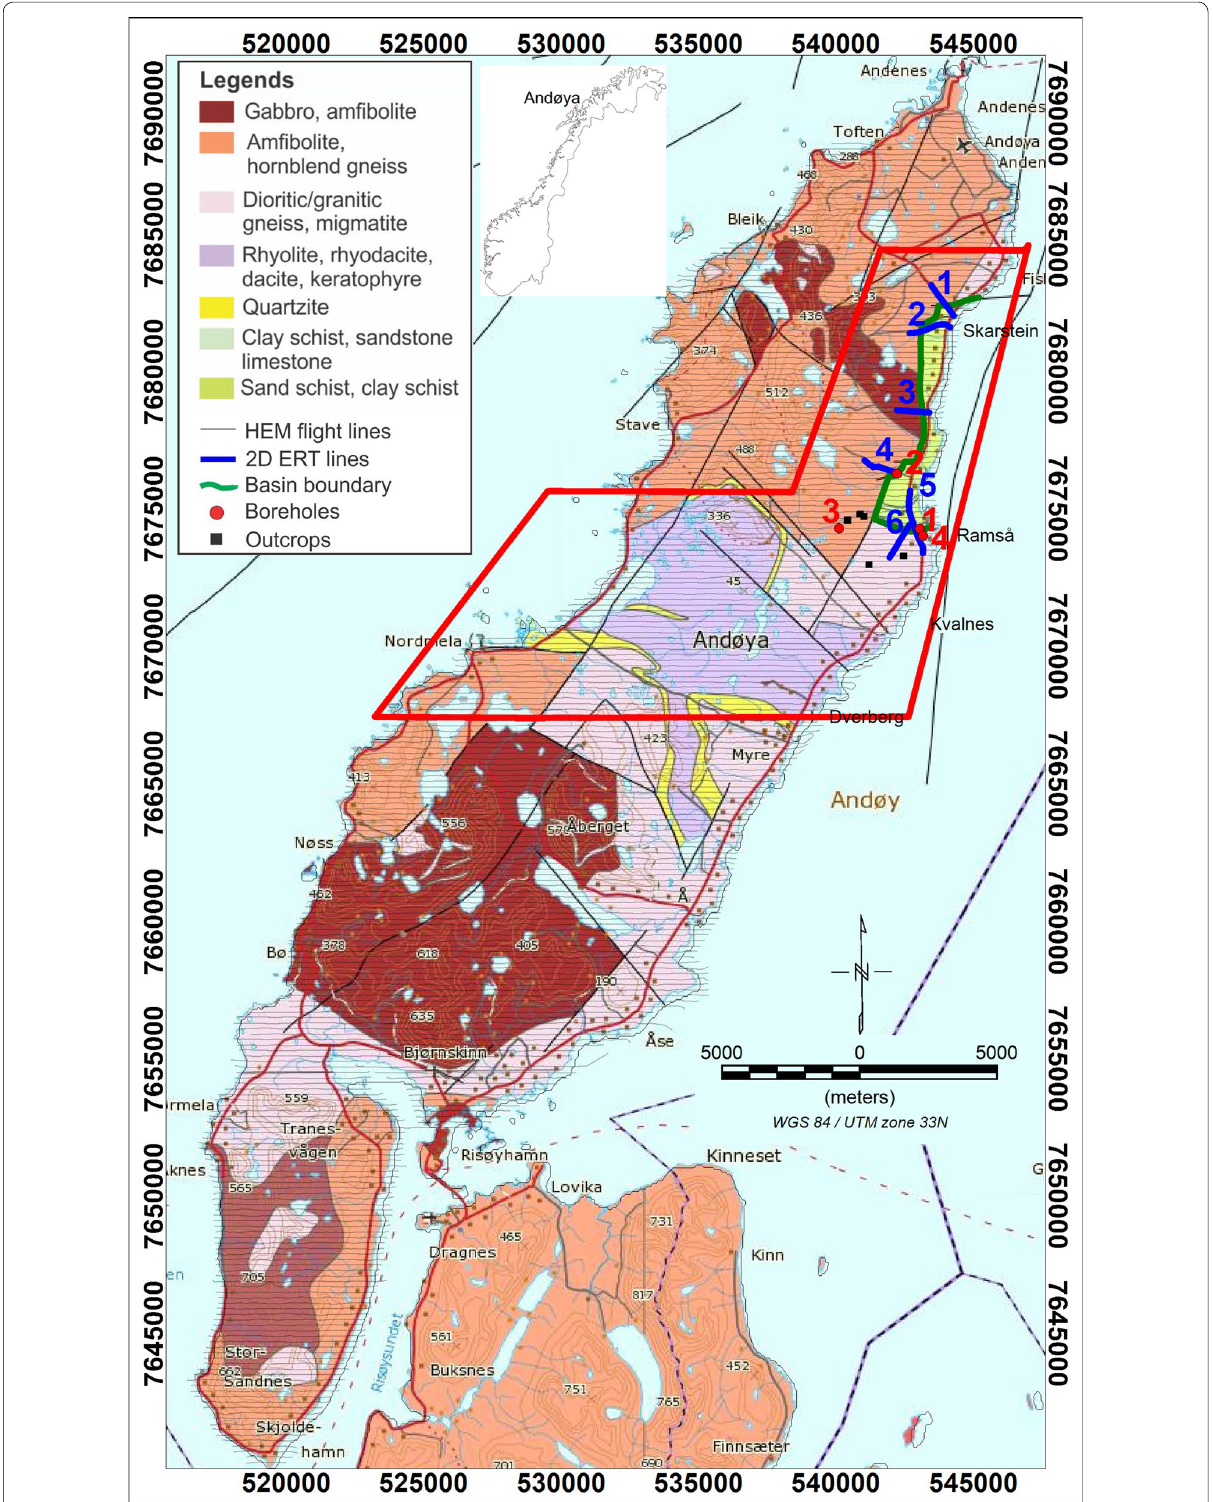
Fig. 1 Bedrock map of Andøya (Henningsen and Tveten 1998) and location of geophysical surveys. Presently assumed western extent of Ramså Basin boundary is shown by green line. Location of various geophysical surveys and basement outcrops (see legends) are also marked. Red polygon shows a part of the HEM data chosen for quasi‑3D